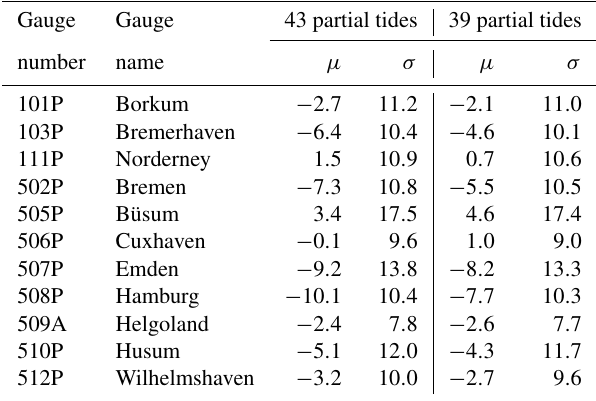
Table 5. Residuals of predicted and observed times of high and low water: mean µ and standard deviation σ in minutes.